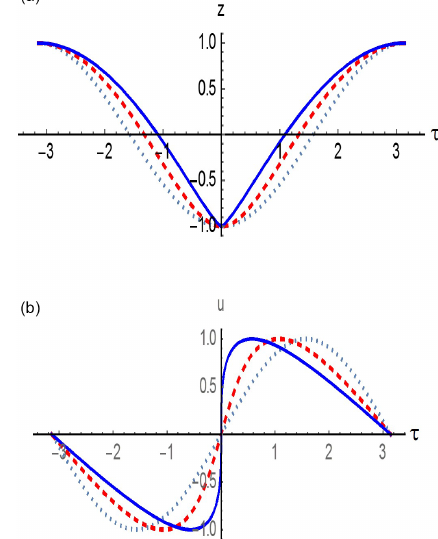
Figure 2. The moving shoreline dynamics (a) and its velocity (b) in the case of the incident monochromatic wave for different breaking parameter values Br (0: the dotted line; 0.5: the dashed line; 1: the solid